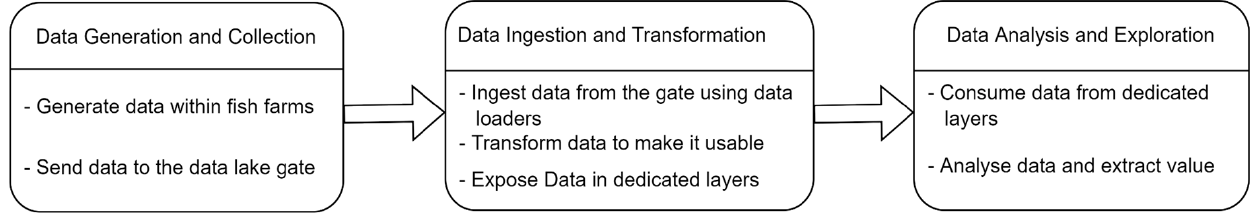
Figure 1. Process of Handling Fish Farming Data.